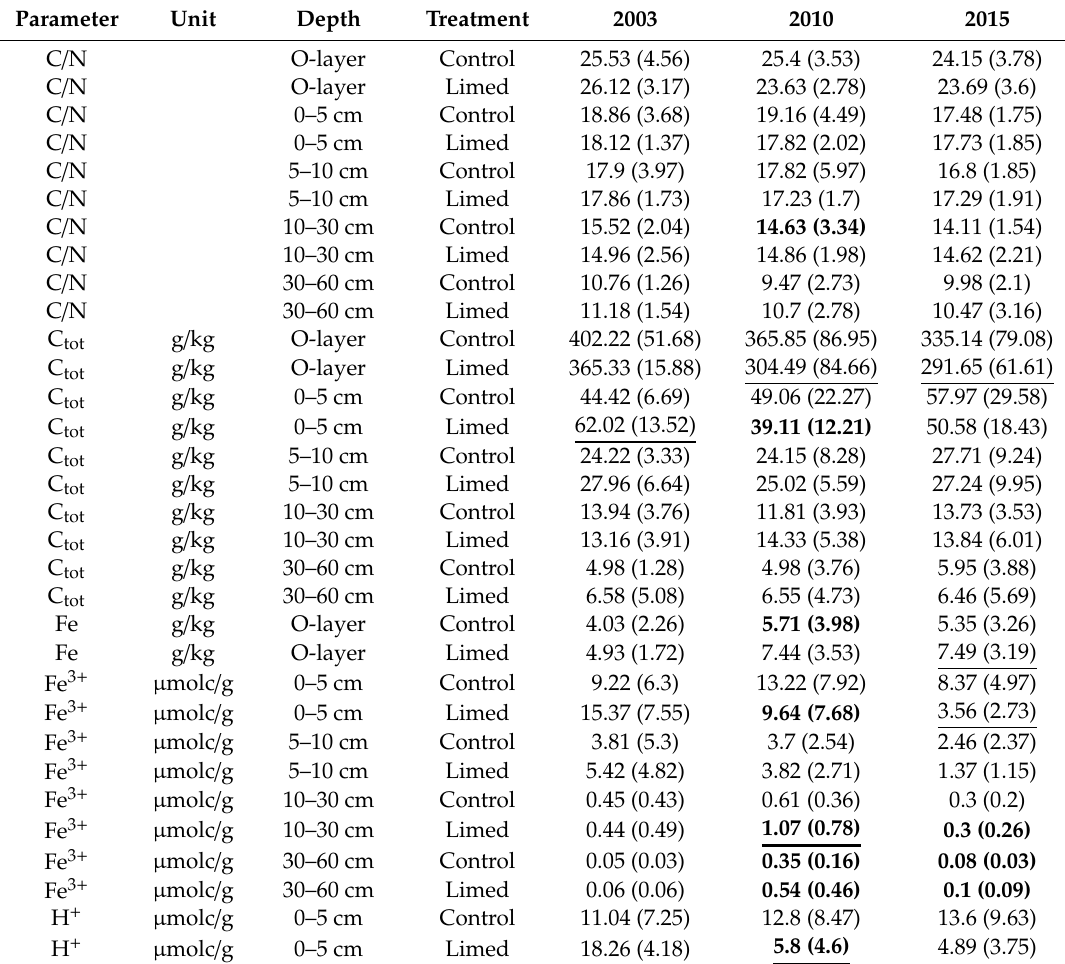
Table A2. G2 study site historic development of pH-KCl, Mg, K, Na, Fe, Mn, H, C and N in 2003-2015; given are group means with standard deviations. Marked bold—significant di ff erences between current and previous sampling campaign, underline—limed plots significantly di ff erent from